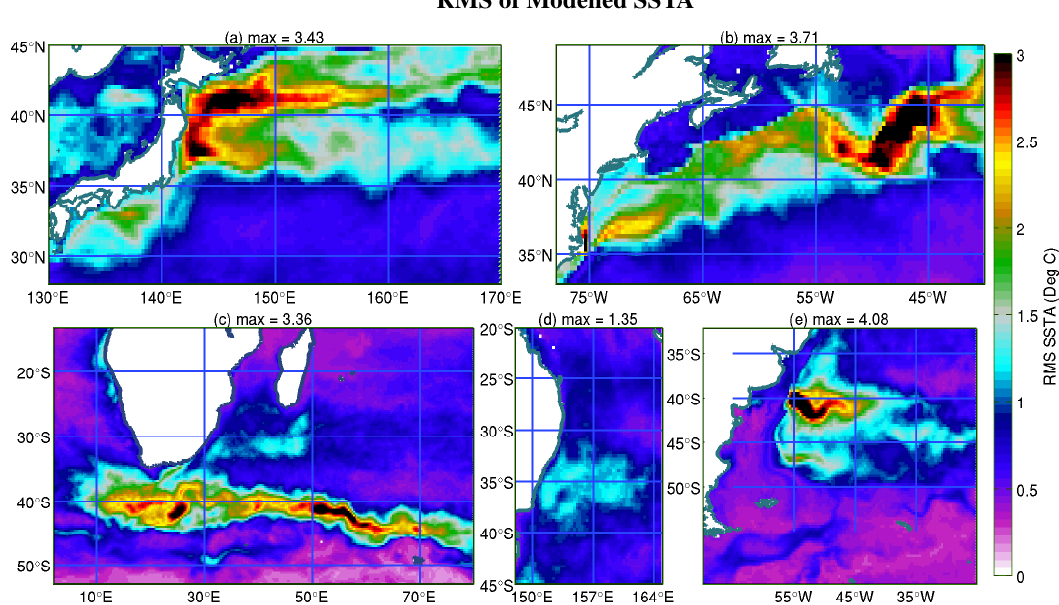
Fig. 13. RMS modelled SSTA for the (a) Kuroshio, (b) Gulf Stream, (c) Agulhas, (d) EAC, and the (e) BMC region. The color scheme is different for different regions according to the inserted legend.